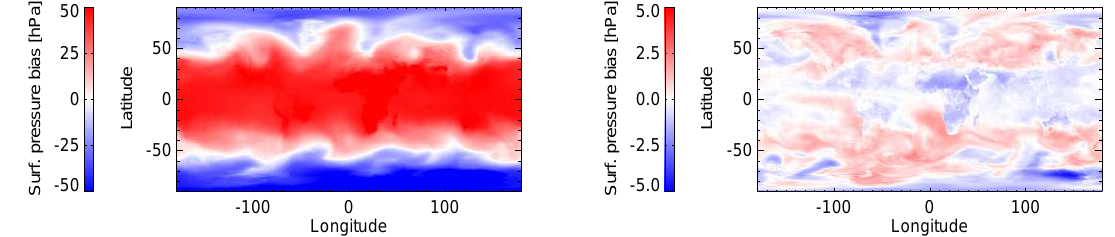
Fig. 6. Global distribution of bias of retrieved surface pressure for a fixed average temperature profile (left) and in the case four temperature eigenvectors are used for the approximation of the transmittance (right), shown for a constant surface pressure of 1000hPa and an airmass of 2.41. Note the different color bars.